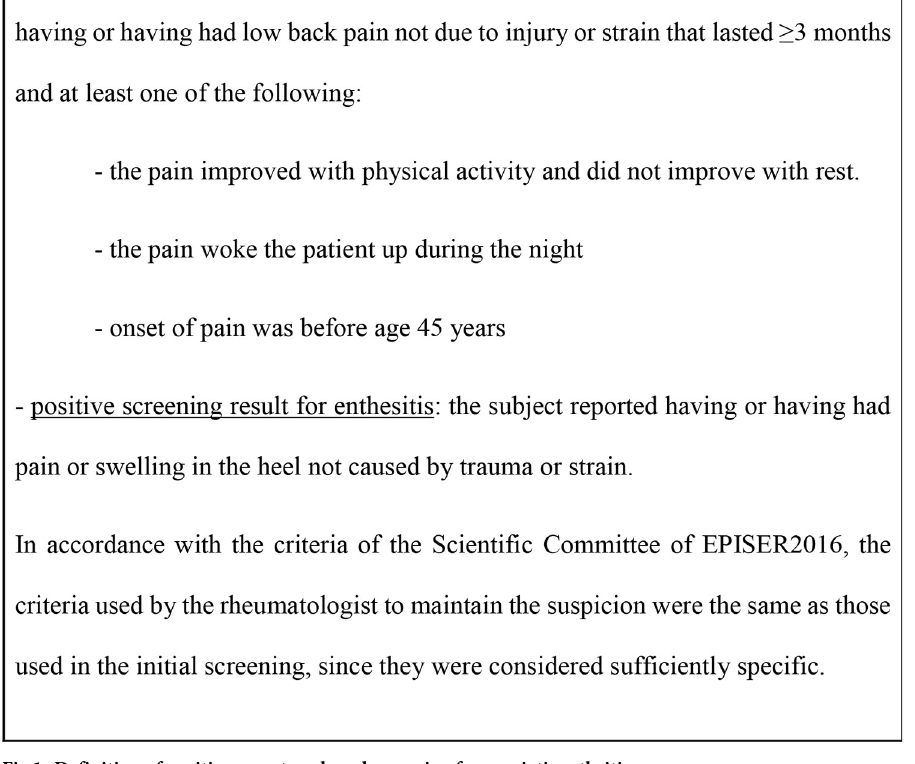
Fig 1. Definition of positive symptom-based screening for psoriatic